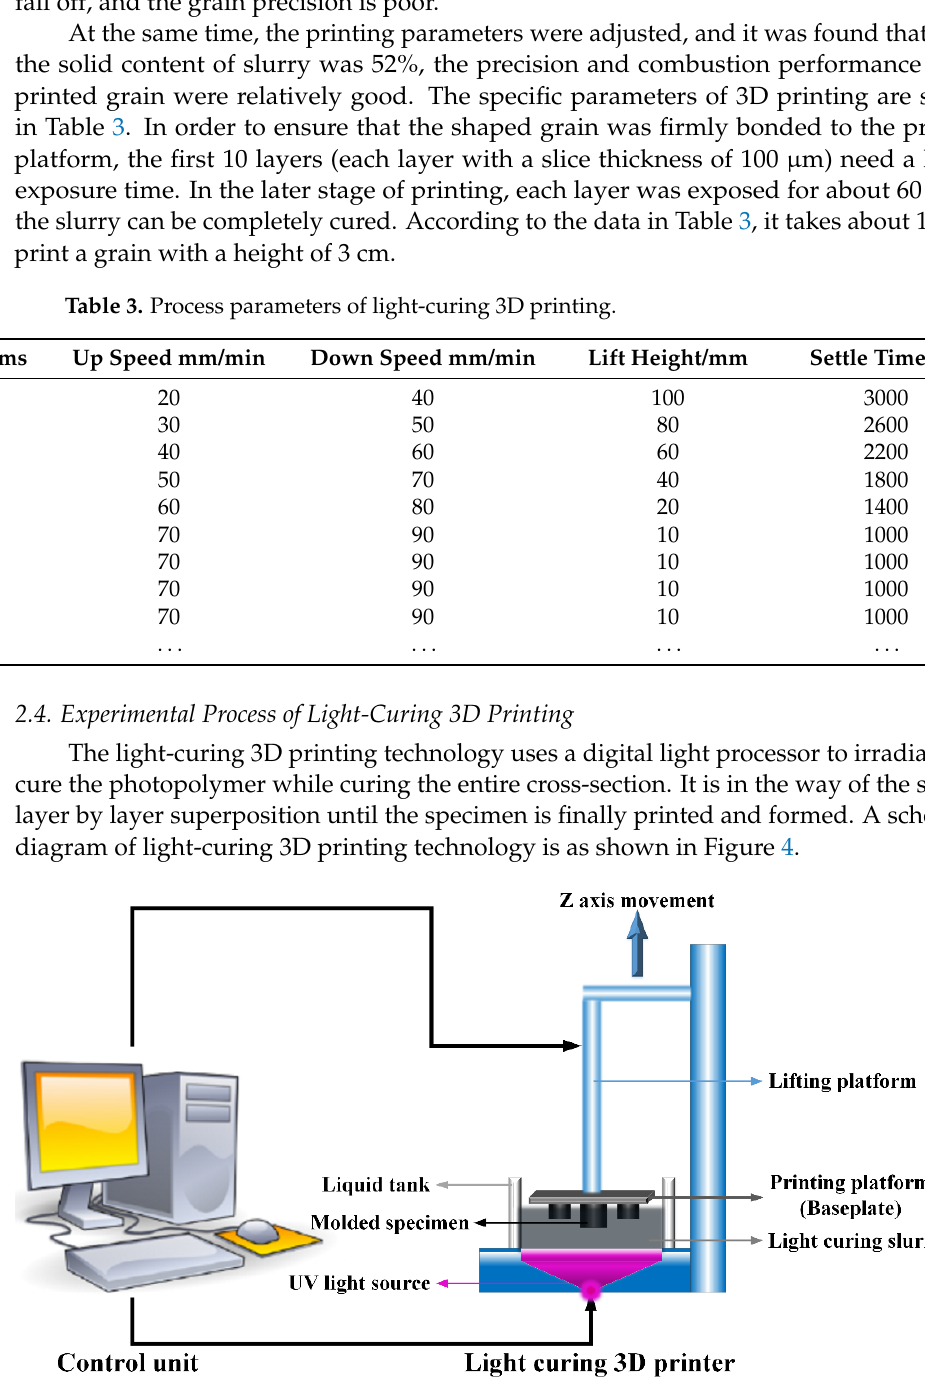
Figure 4. Schematic diagram of light-curing 3D printing technology.